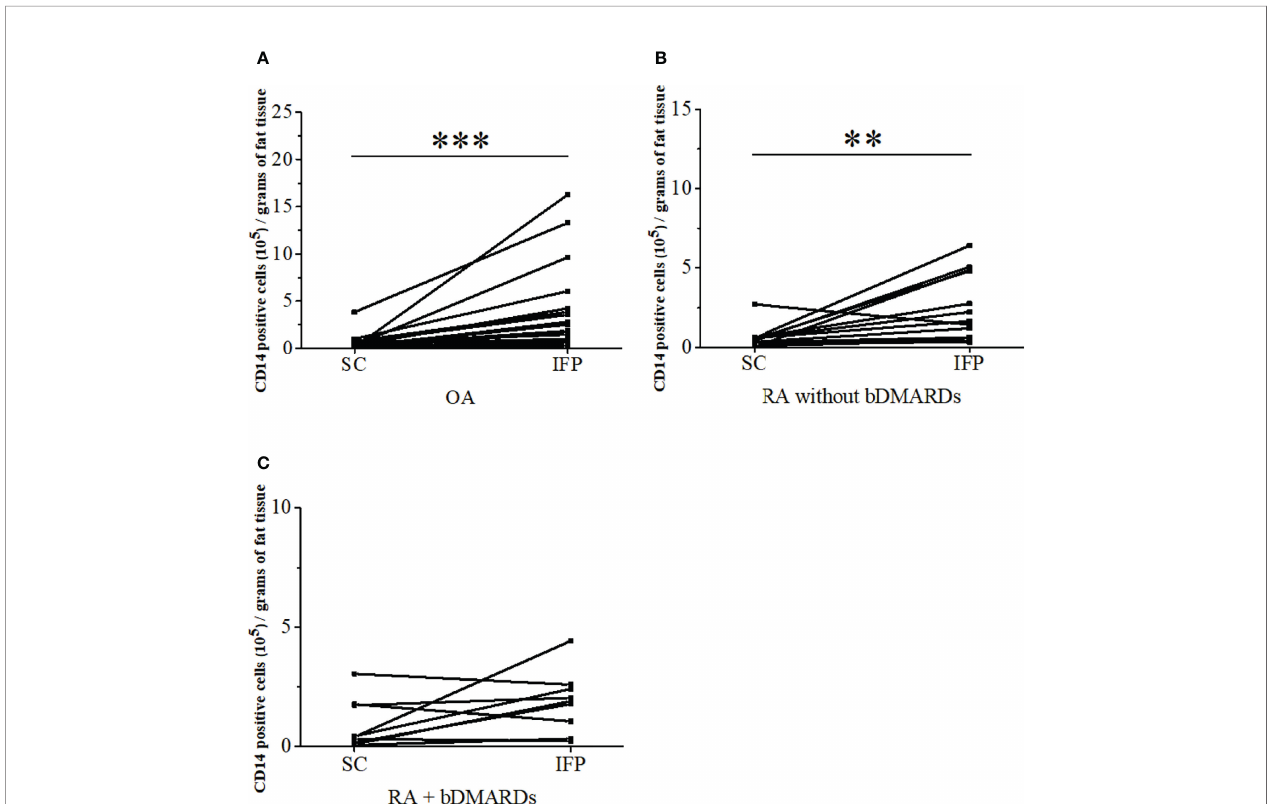
FIGURE 2 | The infrapatellar fat pads (IFP) of arthropathy patients has a higher proportion of CD14-positive cells than the subcutaneous fat tissues. CD14-positive cells per gram of SC or IFP in the osteoarthritis (OA) (A) , rheumatoid arthritis (RA) without bDMARDs (B) , and RA with bDMARDs (C) . Samples were obtained during total knee arthroplasty, digested in collagenase medium to obtain the stromal vascular fraction, and stained with human CD14 antibody to separate adipose-tissue- resident CD14-positive cells. ** p < 0.01 and *** p < 0.001, as determined by the paired-sample Wilcoxon signed-rank test to identify differences between SC and IFP OA. n = 20; RA without bDMARDs, n = 12; RA with bDMARDs, n =